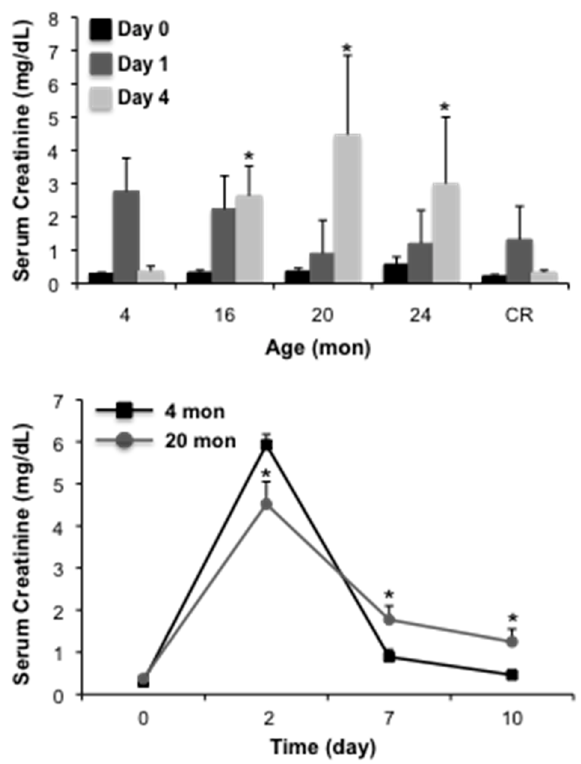
Figure 1. The impact of aging on mercuric chloride-induced acute kidney injury (AKI). Rats were challenged with 2 mg/kg mercuric chloride and AKI was assessed by serum creatinine. In the top panel, rats at different ages were challenged and harvested 1 or 4 days following challenge; In the bottom panel, 20 month (mon) old rats were challenged with mercuric chloride and serum creatinine was assessed 2, 7 or 10 days following injury. Each data point represents the mean + SEM of 3–4 animals, * indicates a significant difference from young control (4 mon).